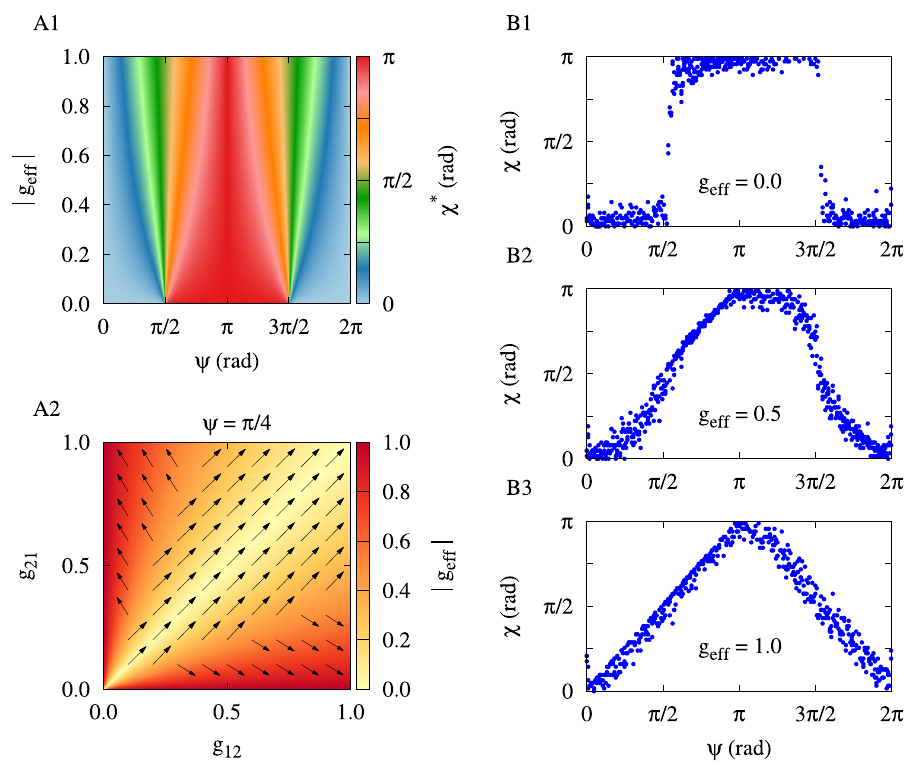
Fig 2. Theoretical and simulation results for the two-neuron motif. ( A1 ) Theoretical prediction of the fixed point of phase lag between the two neurons in terms of the effective synaptic strength and delay calculated by Eq (4). ( A2 ) Theoretical prediction of the two-neuron synaptic change (arrows) in terms of the effective synaptic strength at a given delay (indicated above panel) calculated by Eq (5). ( B1-B3 ) Simulation results of the steady-state phase lag between neurons for different values of the effective synaptic strength (denoted in the figure) are consistent with the theoretical predictions.